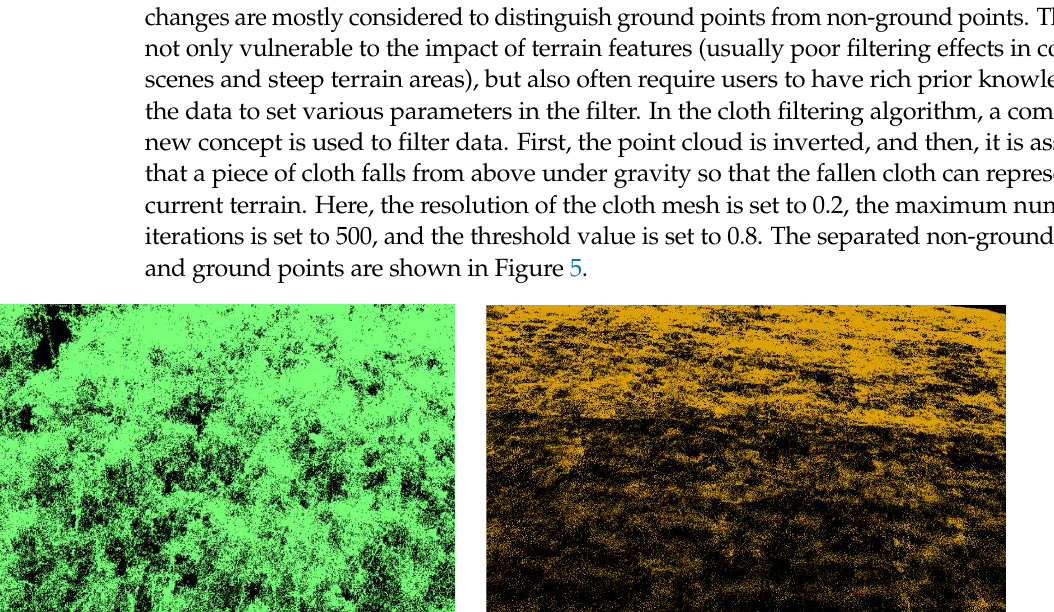
Figure 4. The rendering of denoising step. There are plenty of noise points above the forest before denoising while there are not much after denoising.